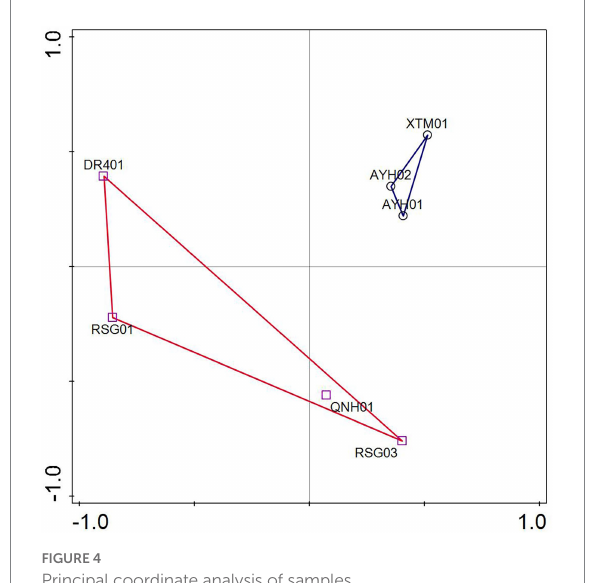
FIGURE 4 Principal coordinate analysis of samples.